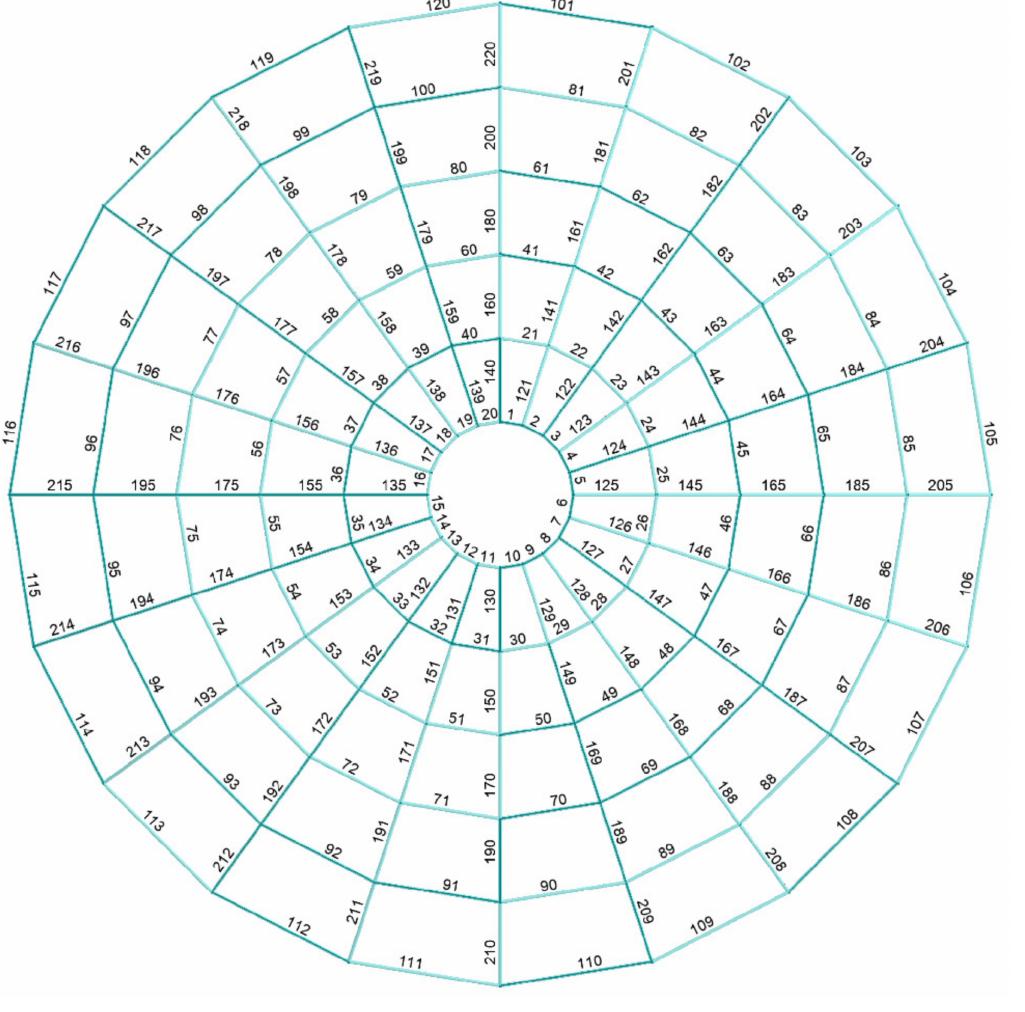
Figure 4. Ribbed